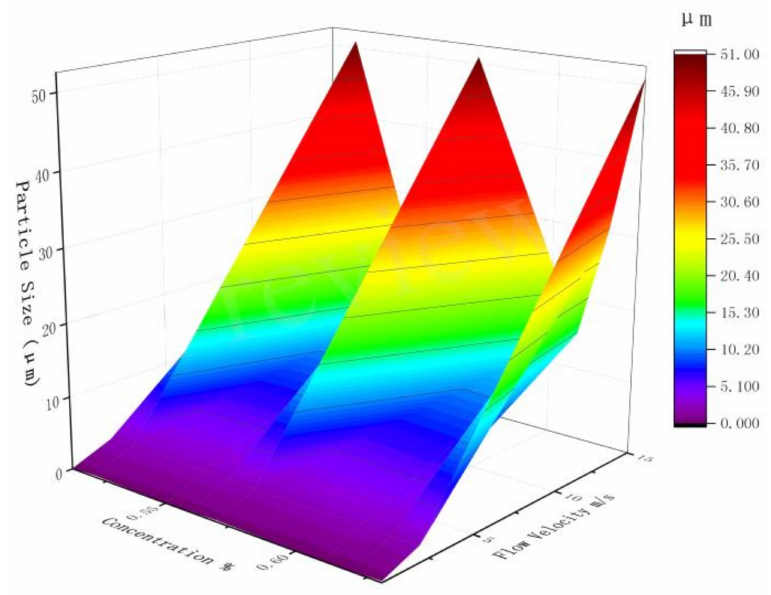
Figure 7. Three-dimensional direct view.